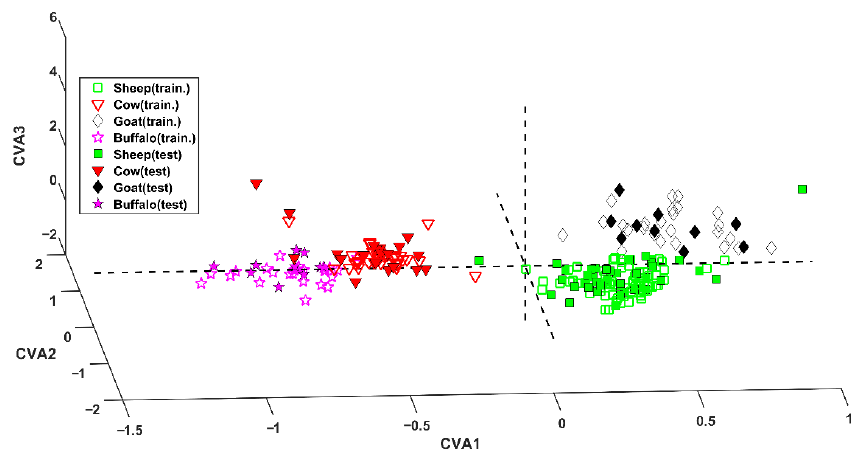
Figure 1. SPORT analysis. Projection of samples onto the space defined by the canonical variates